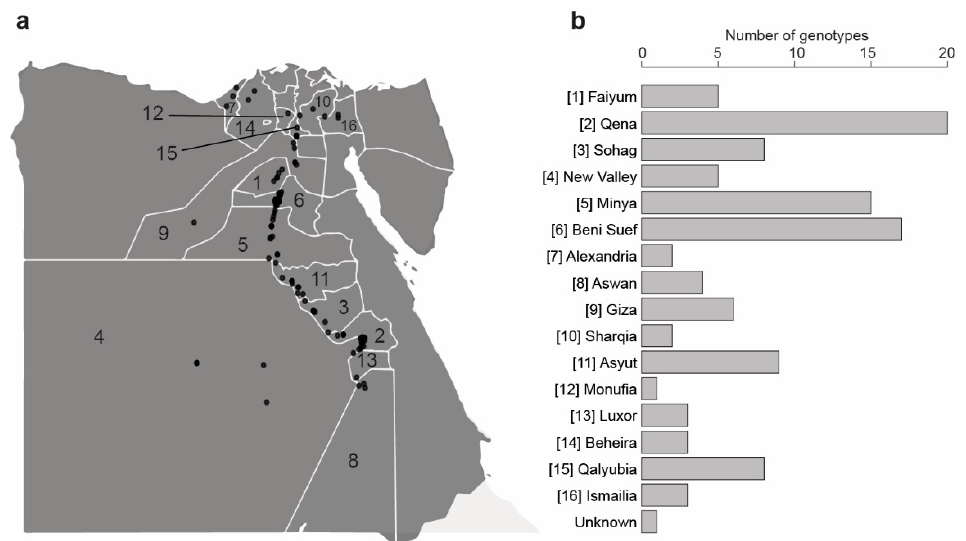
Figure 1. GPS coordinates of the locations where the fenugreek genotypes were collected; please refer to table S1 for further details; a, GPS locations plotting (numbers indicated in the map represent the Egyptian governorates from which genotypes were collected and correspond to those in the panel b); b, horizontal bar-plot showing the number of genotypes of each Egyptian governorate.